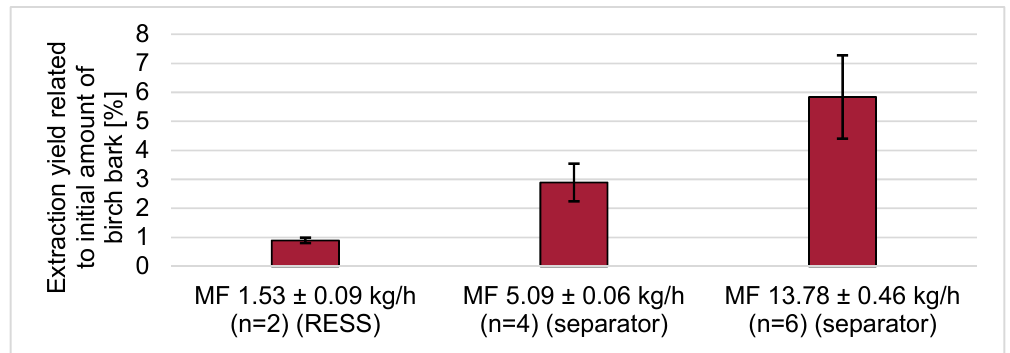
Figure 2. SCF extraction yield (birch bark extract) depending on carbon dioxide mass flow (MF) by different extraction and deposition methods (RESS/separator); n : number of independent productions, mean ± SD; mean ± span width for RESS.